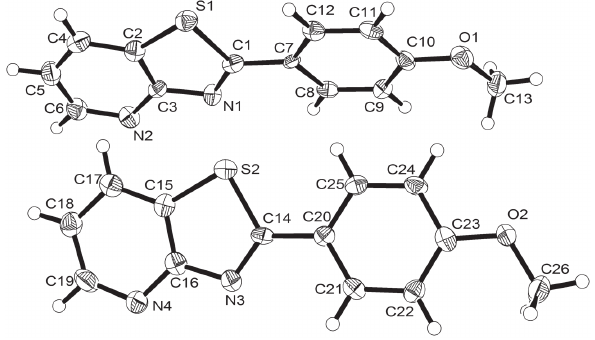
Table 1: Data collection and handling.